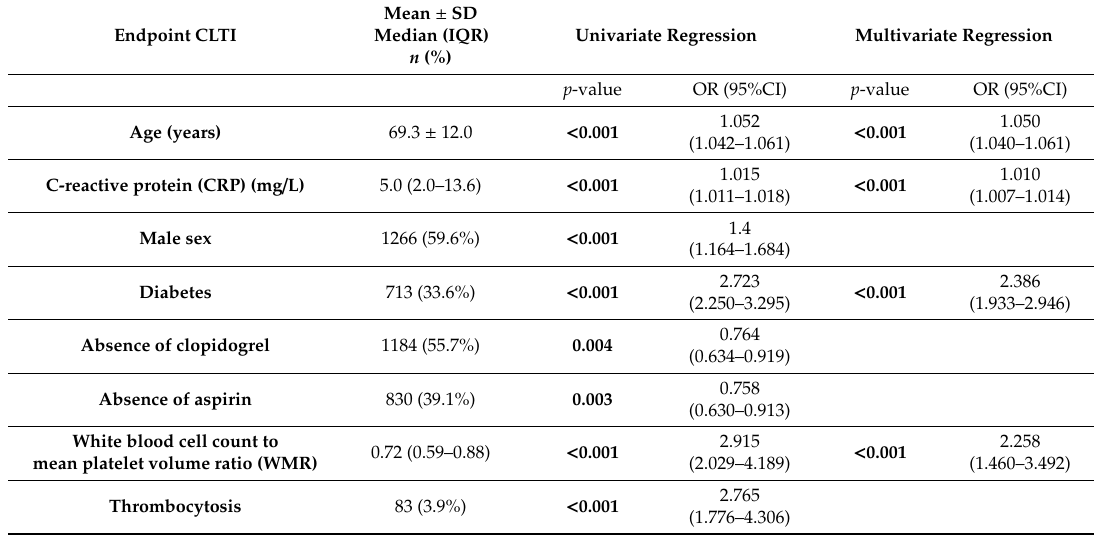
Table 2. Univariate and multivariate regression analysis for the endpoint of chronic limb-threatening ischemia